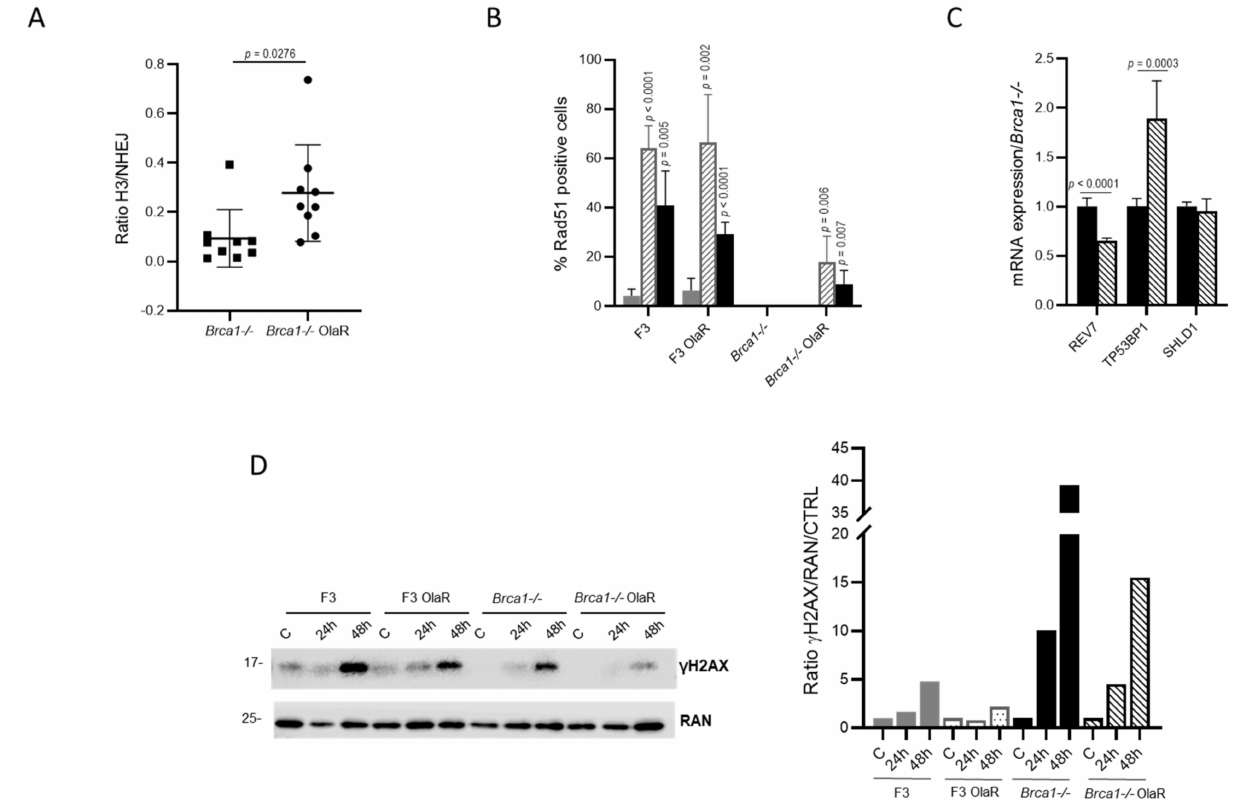
Figure 4. Homologous recombination repair in olaparib-sensitive and -resistant cells. ( A ). Basal levels of homologous repair and NHEJ by analyzing pathway-specific DSB repair of GFP-based reporter plasmids HR-EGFP/3 (cid:48) EGFP and EJ5SceGFP transfected in the sensitive and resistant cells with the I- Sce I meganuclease expression plasmid as detailed in Material and Methods. Data are expressed as the ratio between homologous repair (HR plus single-strand annealing, SSA) and NHEJ efficiency; each dot represents a single experimental point. ( B ). Percentage of RAD51 positive cells treated or not with olaparib (filled black column) and IR (patterned grey column) at 24 h. A representative experiment is shown. For statistical analyses of treated cells over the control unpaired t -test was used ( C ). mRNA expression of REV7, TP53BP1 and SHLD1 in Brca1-/- (filled black column) and Brca1-/- OlaR (patterned black column). Values are normalized by actin mRNA expression and are the mean of three independent experiments, run in triplicate, and are expressed as fold-change over Brca1-/- values. ( D ). Western blot analysis of γ H2AX after olaparib treatment and its densitometric quantification. For statistical analyses unpaired t -test was